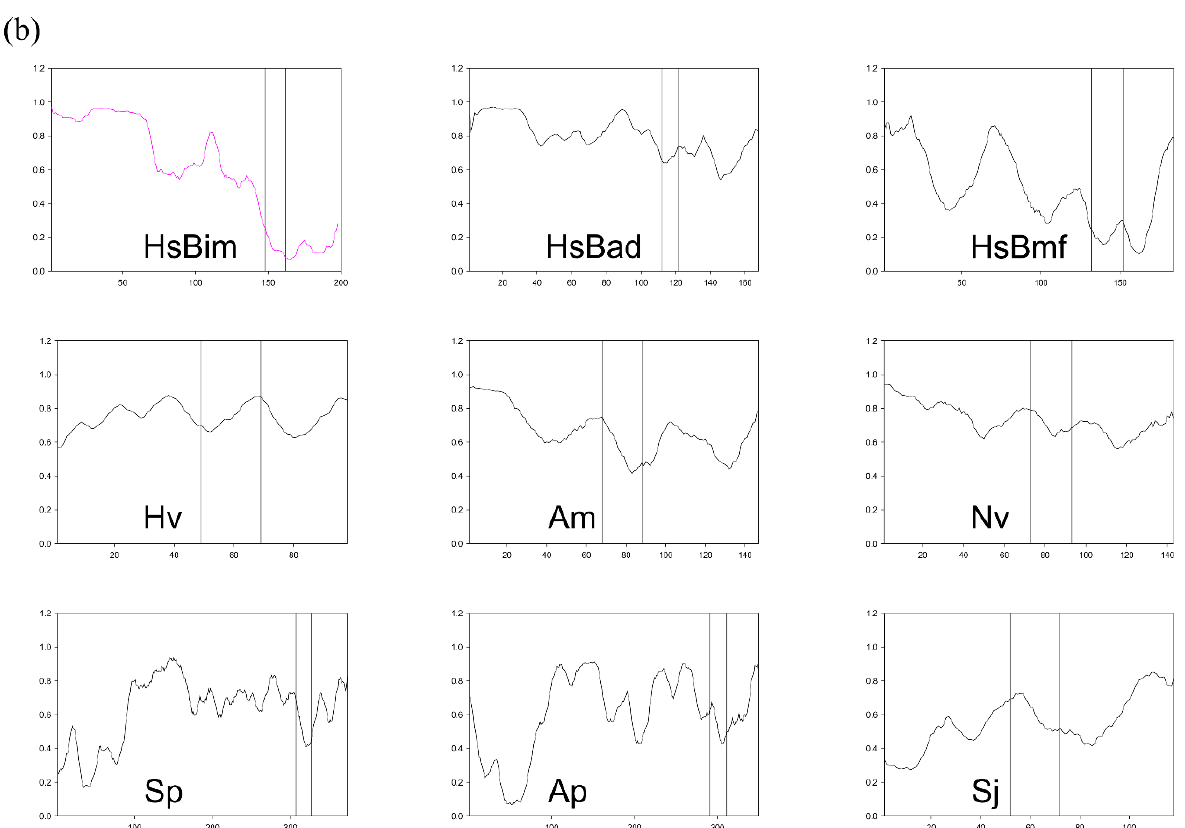
Figure 5. Potential BH3-only proteins from selected early metazoans ( a ) multiple protein sequence alignment of gene structures protein sequences of the BH3 region only are shown. Cnidarian BH3- only genes lack introns. The key conserved leucine and aspartate of the BH3 region are highlighted. ( b ) The disordered nature of BH3-only proteins is conserved. Plots of averaged predicted IDP indices versus sequence position for human and hypothesised Cnidarian BH3-only proteins. Analysis